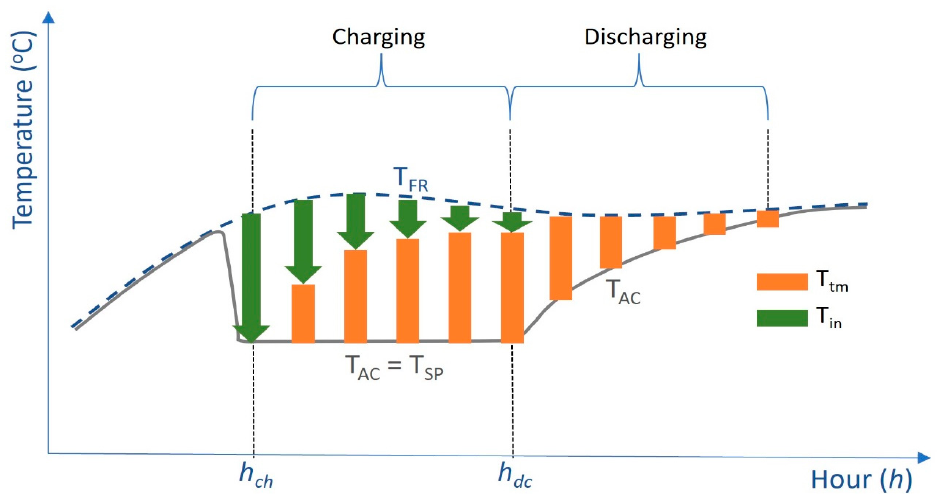
Figure 1. Time-series plot illustrating the typical behaviour of temperatures T FR , T AC , T tm , and T in during the charging and discharging phase.